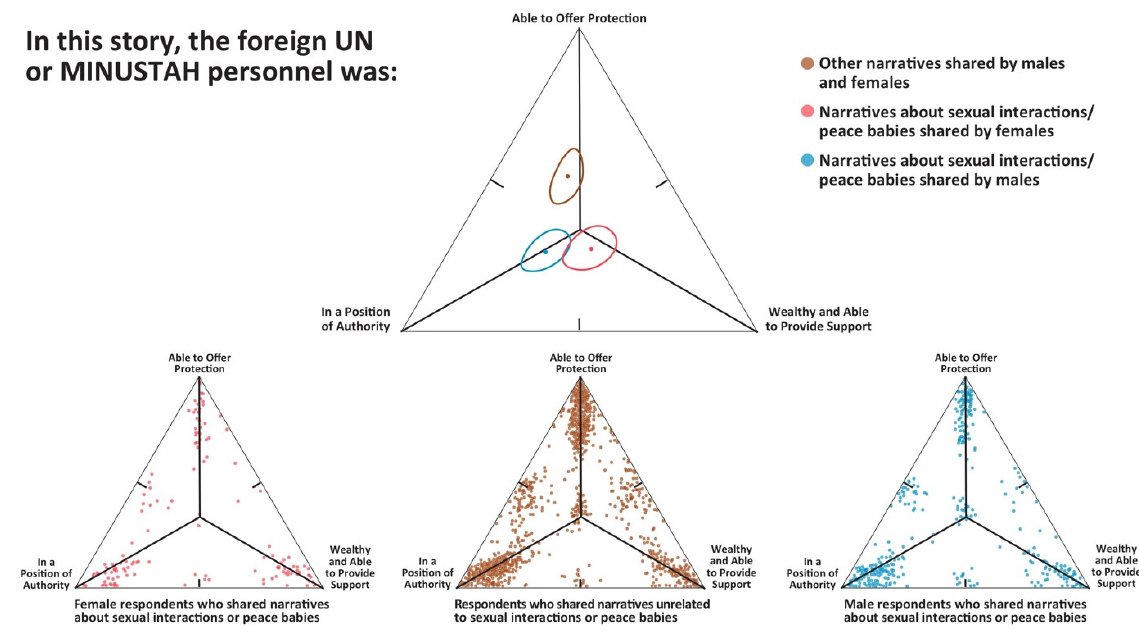
Figure 4. Disaggregated geometric means for Triad 2 .